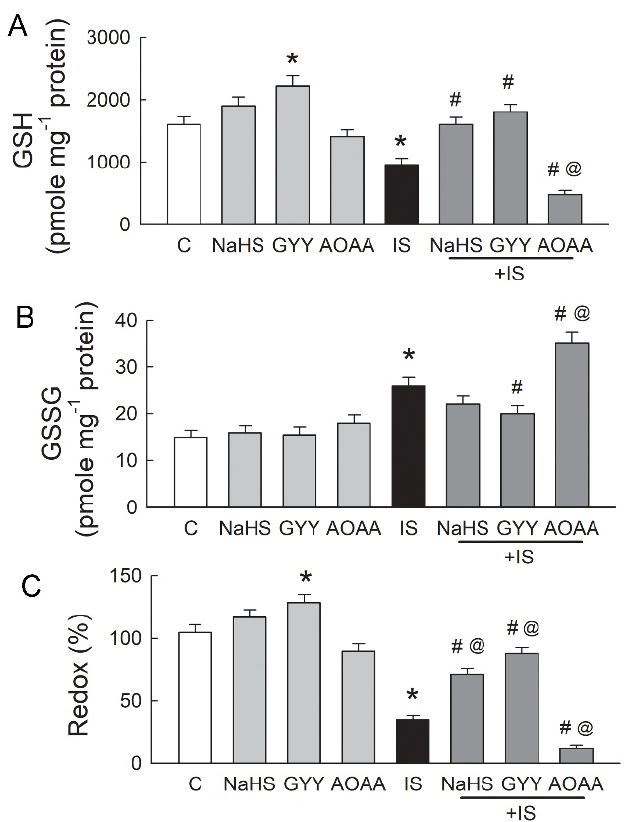
Figure 7. Supplementation with H 2 S reverses the poor redox status caused by IS. ( A ) Cellular glutathione (GSH) content in cells after 48 h of treatment with the vehicle solution (C, control), H 2 S donor NaHS (100 µ M), GYY-4137 (GYY, 50 µ M), H 2 S inhibitor AOAA (100 µ M), or IS in alone or in combination. ( B ) Cellular glutathione disulfide (GSSG) content in cells following the same treatments mentioned above. ( C ) The GSH redox ratio represents the index of antioxidant defense in cells after various treatments. N = 6 in each group. * p < 0.05, drug vs. control (C) group; @ p < 0.05, drug + IS vs. IS group; # p < 0.05, drug + IS vs. drug only group.